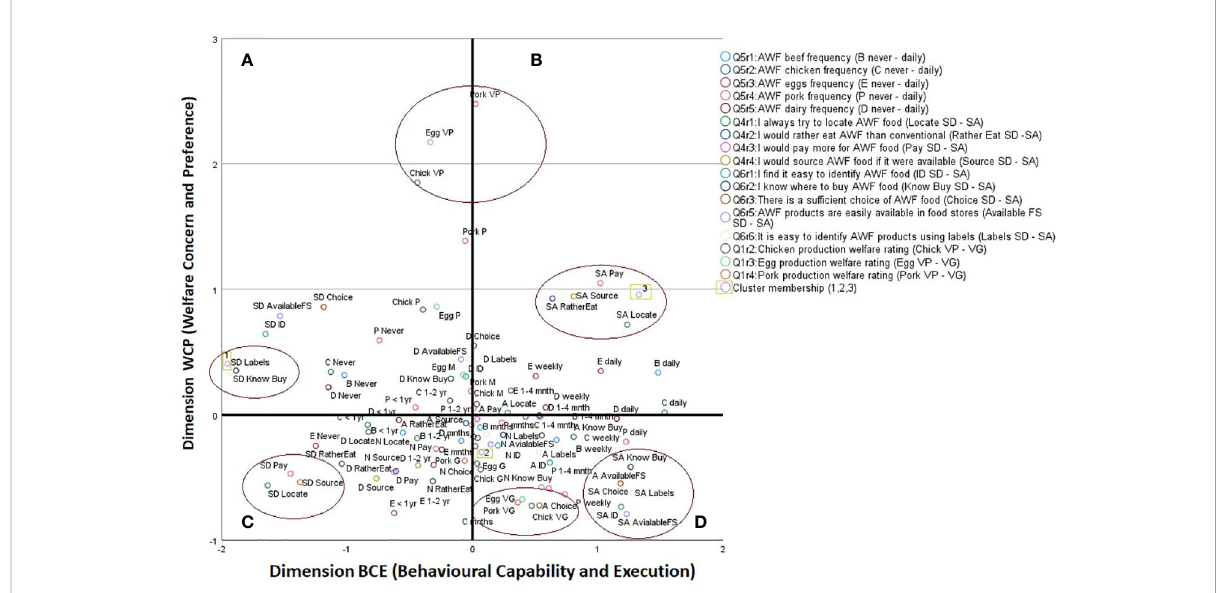
FIGURE 1 Multiple category centroid plot from NLCCA. Quadrant B represents the optimal positioning for daily purchase frequency of FAW friendly food. Food purchase frequency (Q5) of animal welfare friendly (AWF) products for each food group range on a seven point scale from never to daily. Attitudinal statements (Q4, Q6) range on a seven point scale of strongly disagree (SD) to strongly agree (SA). Cluster membership denoted where 1 represents the Struggling, 2 the Indifferent, and 3 the Engaged. The graph is interpreted by using four quadrants labeled (A – D) . Category centroids are displayed in different